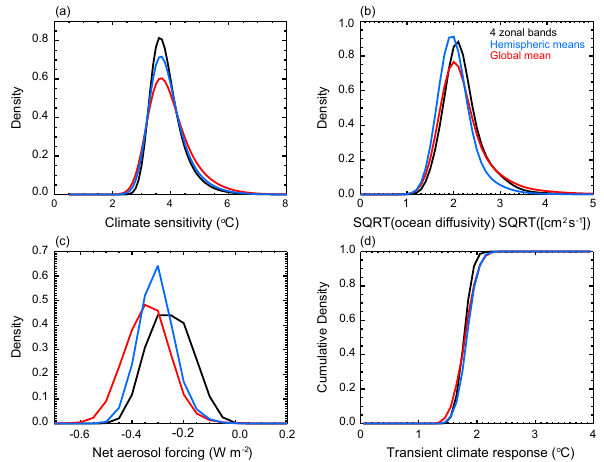
Figure 12. Marginal probability distribution functions for (a) ECS, √ K v , and (c) F aer and (d) cumulative distribution function for (b) TCR derived from different spatial diagnostics. Diagnostics end in 2010 and data are added by extending the